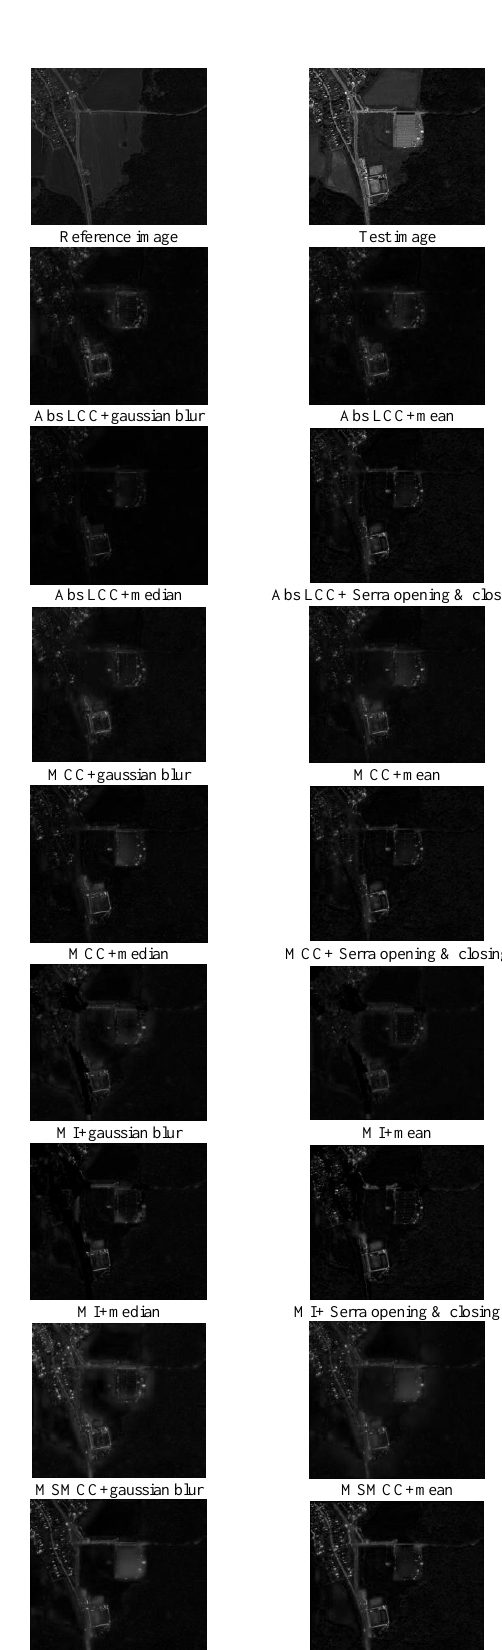
Figure 4. Example of morphological difference maps based on guided contrasting with various combinations of LSC and SO (remote